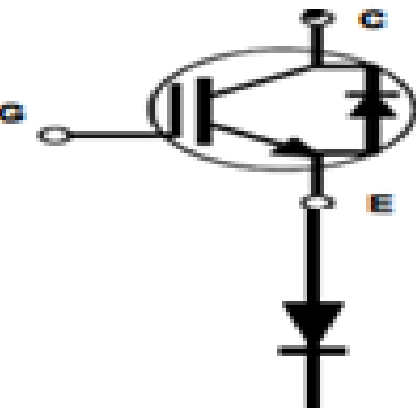
Figure 9. FGA15N120 in series with blocking diode.